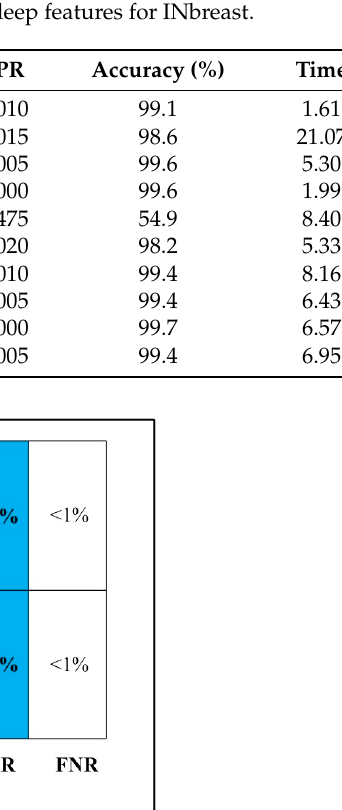
Table 19. Classification results using MEWOA on Fusion deep features for INbreast.